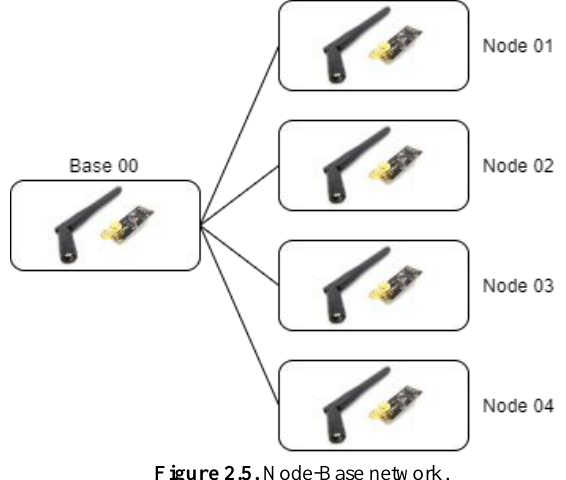
Figure 2.5. Node-Base network.